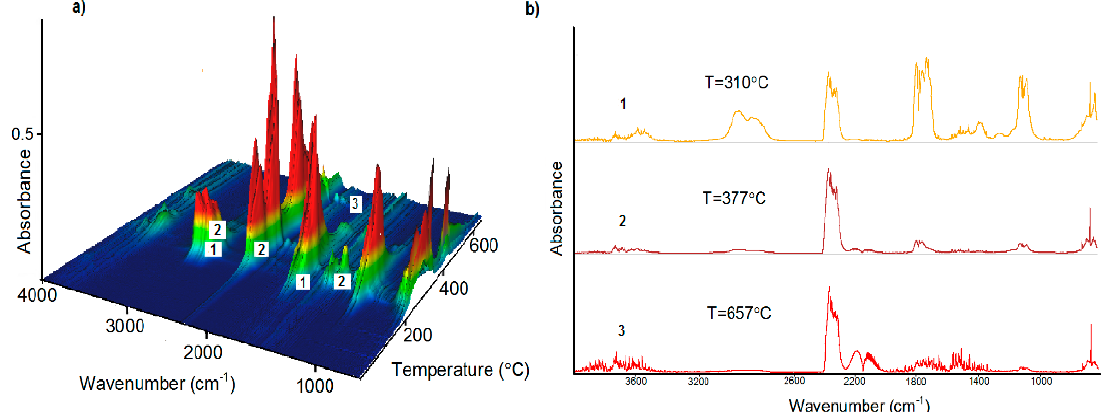
Figure 7. ( a ) 3D representation of FTIR spectra of evolved gases during decomposition of 1 ; and ( b ) FTIR spectra of gaseous products recorded at different temperatures.